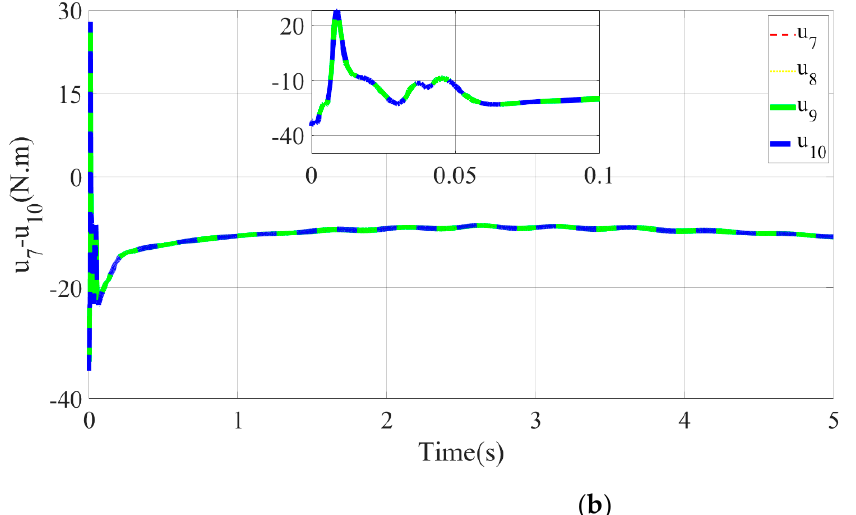
Figure 16. Input torque curve of each PMA. ( a ) Input torque of PMA1-4. ( b ) Input torque of PMA5-8.